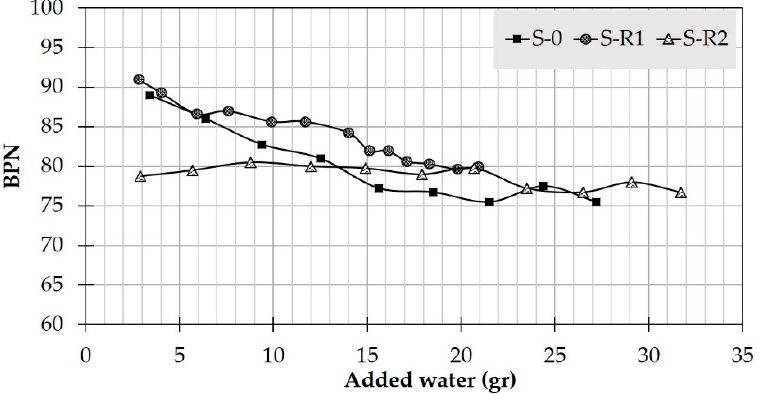
Figure 18. BPN levels during phase (5)—“water addition up to cleaning” for the S-0, S-R1, and S-R2 specimens.